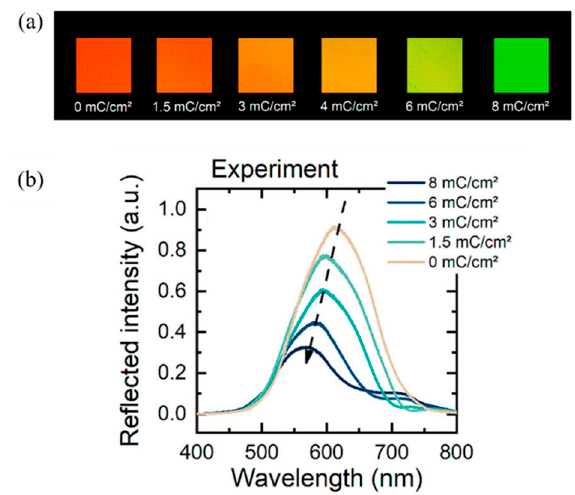
Figure 12. ( a ) 100 μ m × 100 μ m raw images of reflected color at different applied current densities. Images are taken with a CMOS camera. ( b ) Experimentally obtained normalized reflectance at different charge densities. Reprinted with permission from ref. [122] Copyright (2020) American Chemical Society.